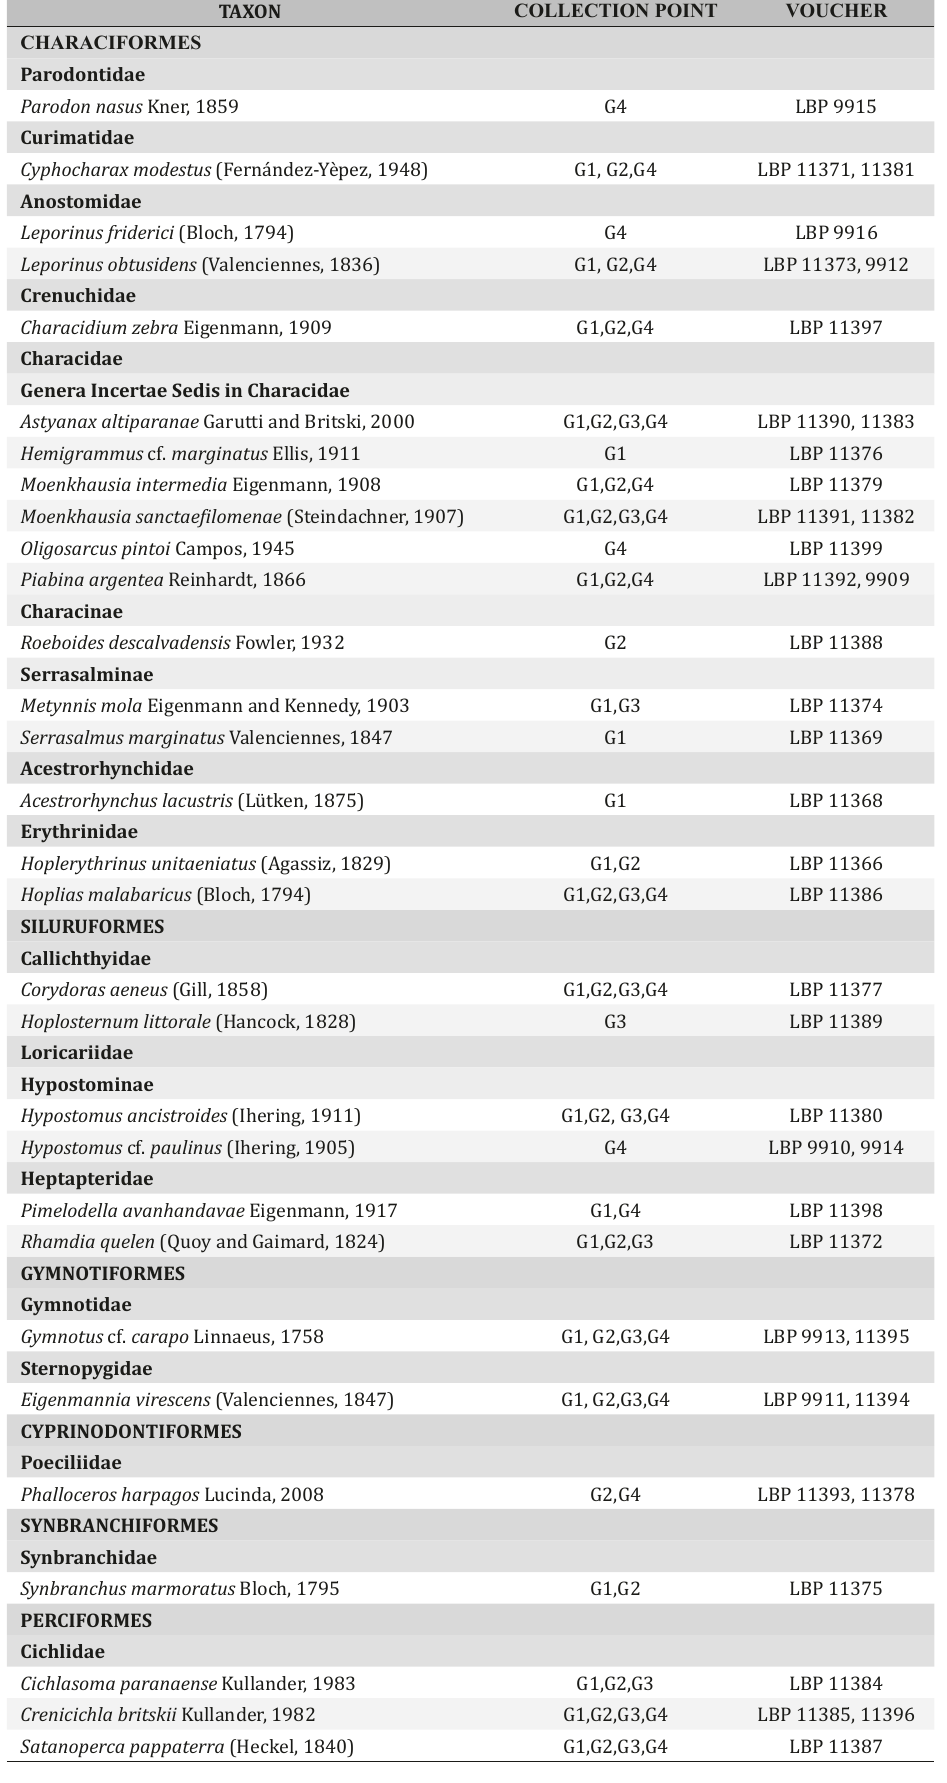
Table 1. List of the species captured in Riacho Goulart, following the taxonomic classification system by Reis